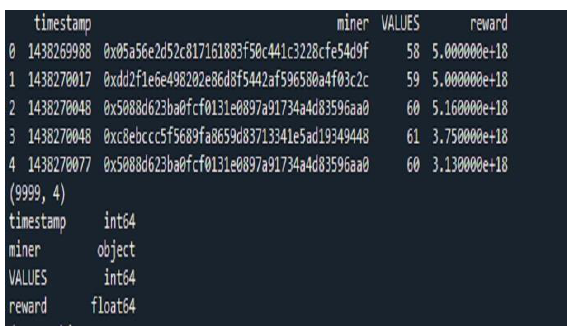
Fig 1. The head of the Ethereum block dataset.